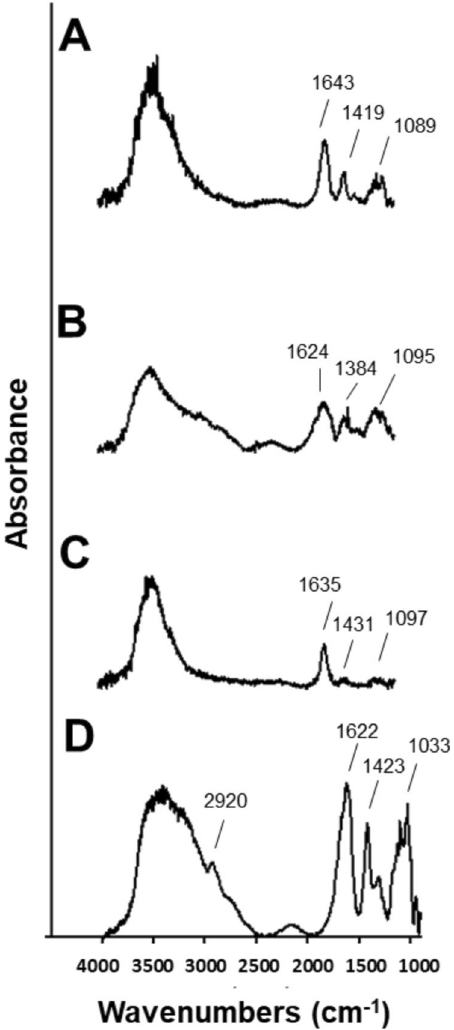
Figure 2. Fourier-transfrom infrared spectroscopy (FTIR) spectra of calcium alginate microcarriers fabricated with different parameters ( A ) F1, ( B ) F2 and ( C ) F3, indicates that F1, F2 and F3 contain the –OH (3000 to 3600 cm −1 ), –COO– (1342, 1423, 1622 cm -1 ), –C–C–H, –C–O–H, –C–O (935 to 1107 cm −1 ) linkages compared to sodium alginate ( D ), and F1 ( A ) is more similar to control ( D ).